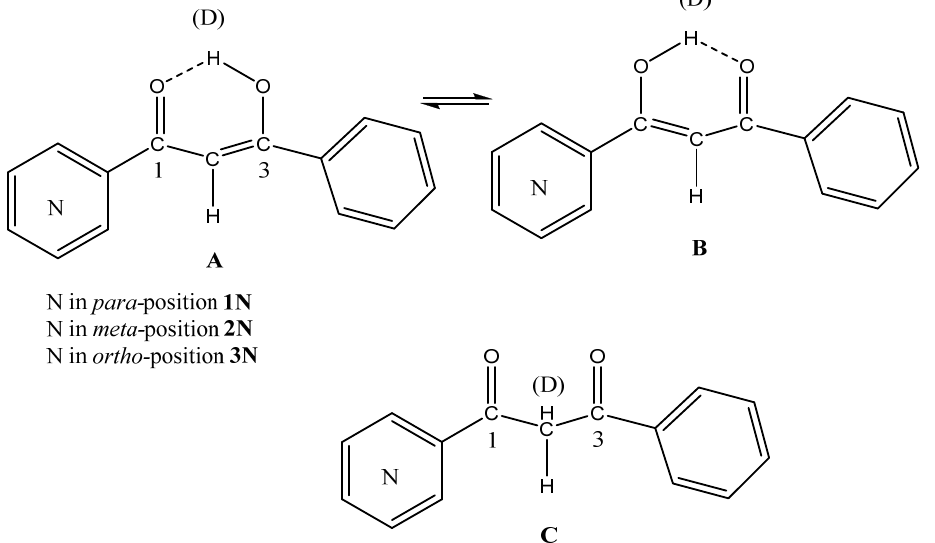
Scheme 4. Tautomerism of pyridoylbenzoyl β -diketones. Only very small amounts of the diketo-form were found.